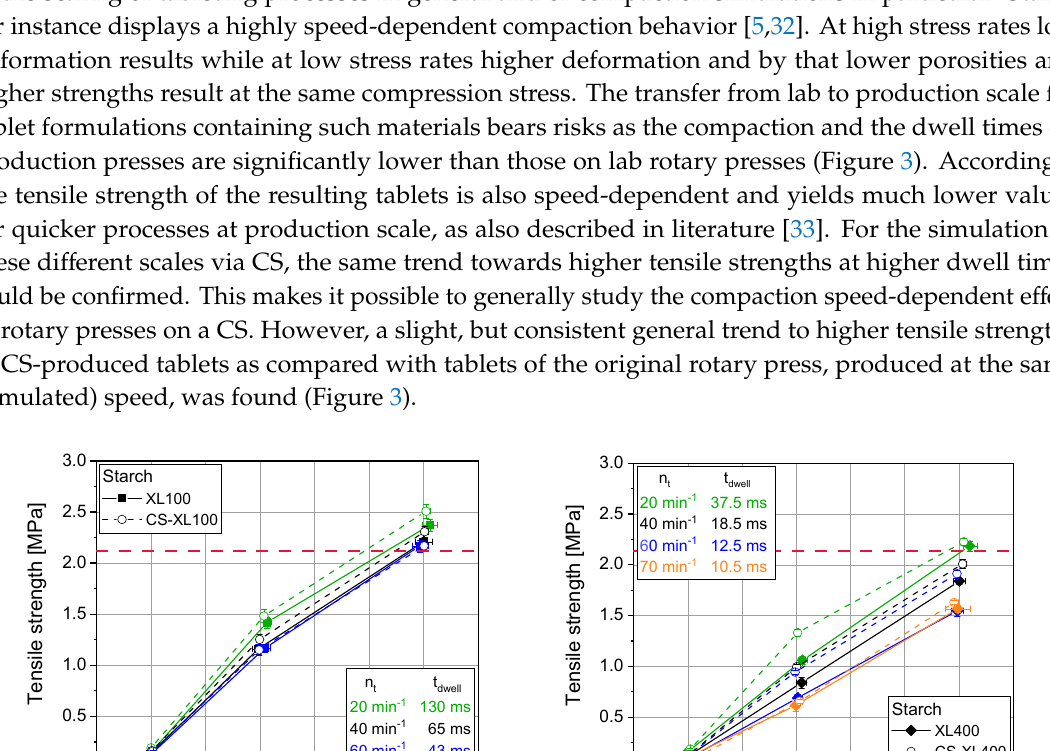
Figure 2. Influence of blend composition (anhydrous dicalcium phosphate/microcrystalline cellulose) on tabletability for XL100 and its simulated profile (CS) applying 11.28 mm punches, respectively. n = 10 .